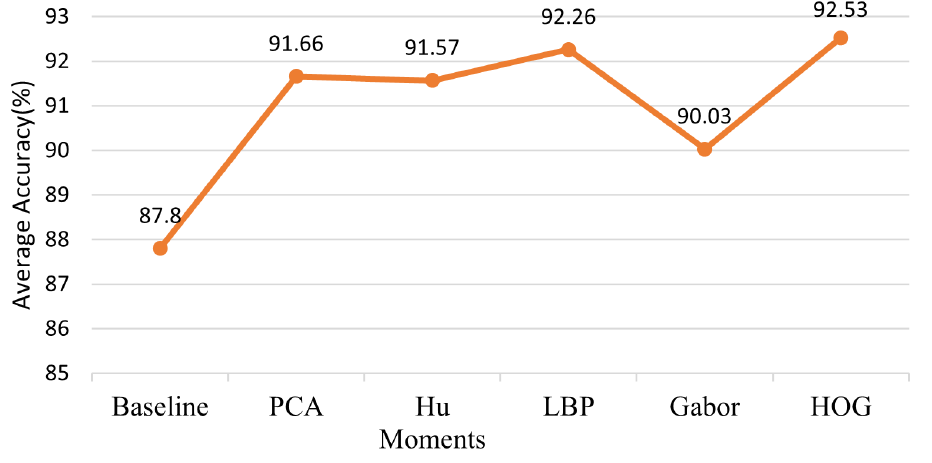
Figure 13. The results of inserting different hand-crafted features.